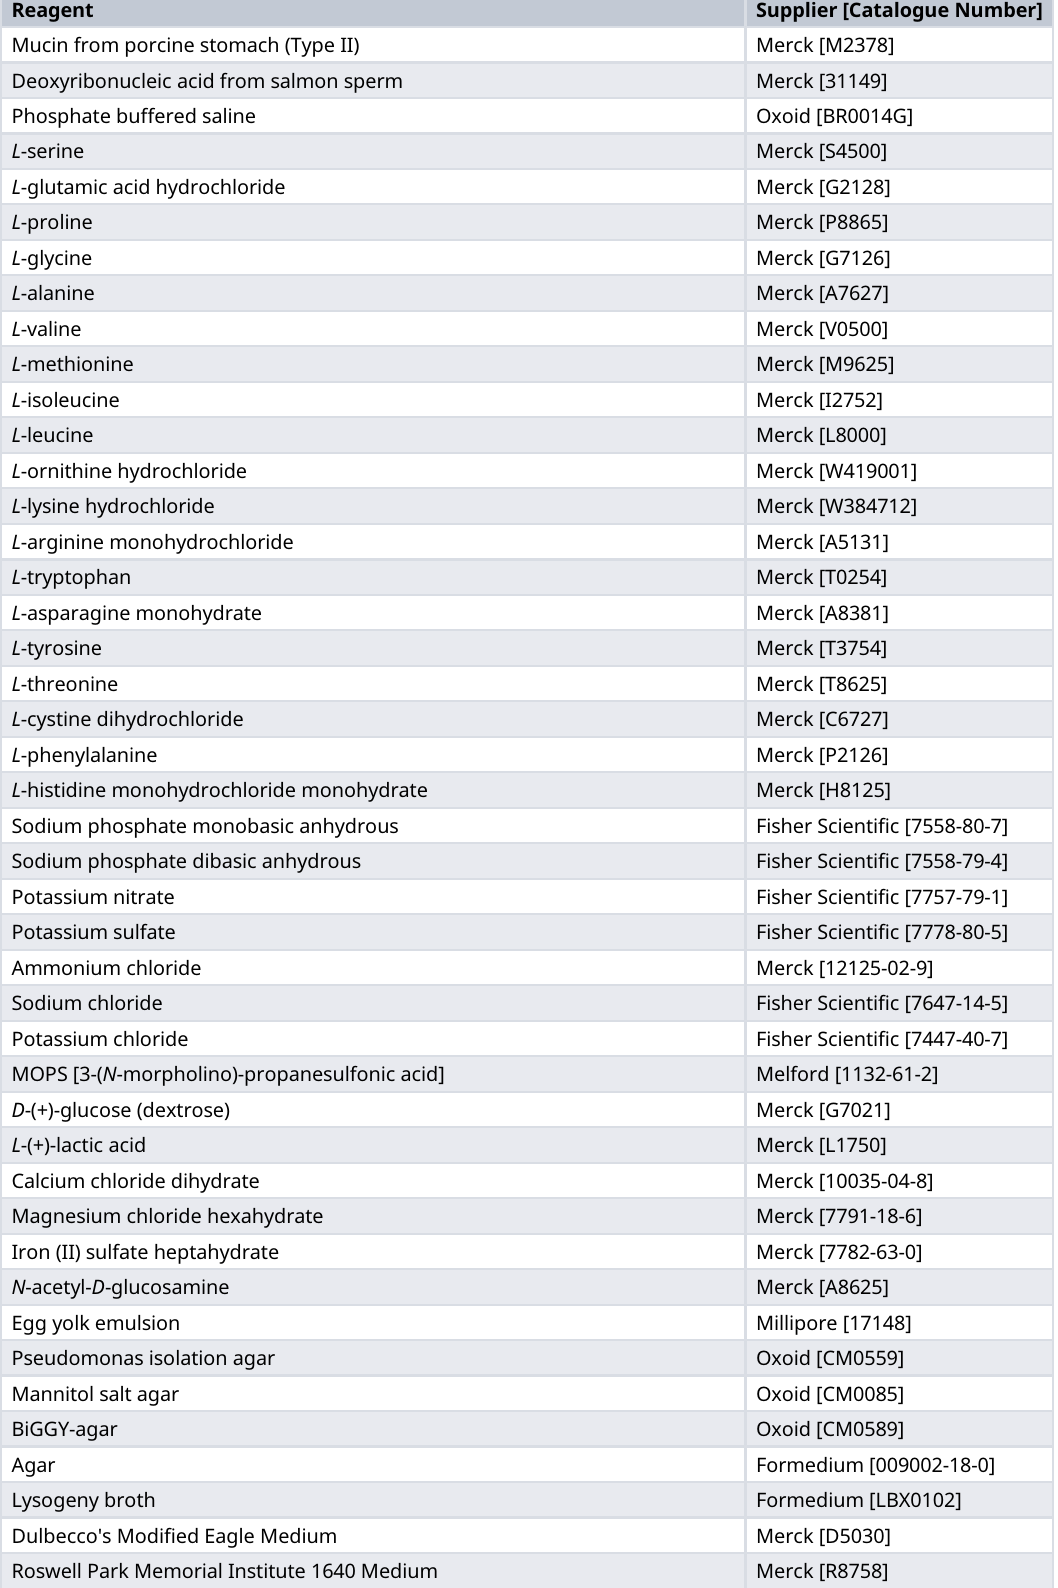
Table 2. Reagents used in this